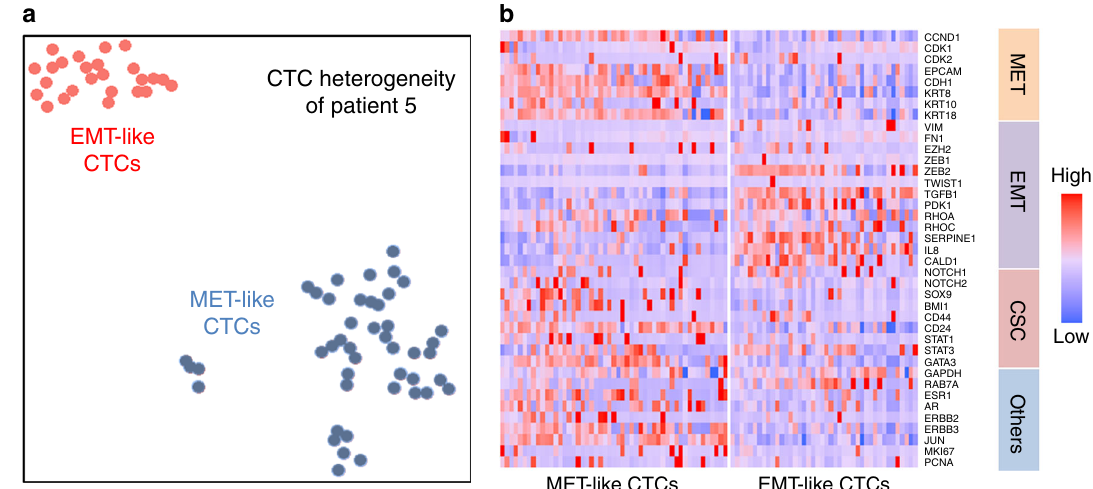
Fig. 5 CTC intra-patient heterogeneity of EMT-like and MET-like states. a 78 CTCs from the same patient sample were plotted based on tSNE clustering method, demonstrating a clear separation between MET-like and EMT-like CTC populations. b Heatmap shows the signi fi cant gene expression differences between two populations in EMT, MET, and CSC related genes. Source data are provided as a Source Data fi le